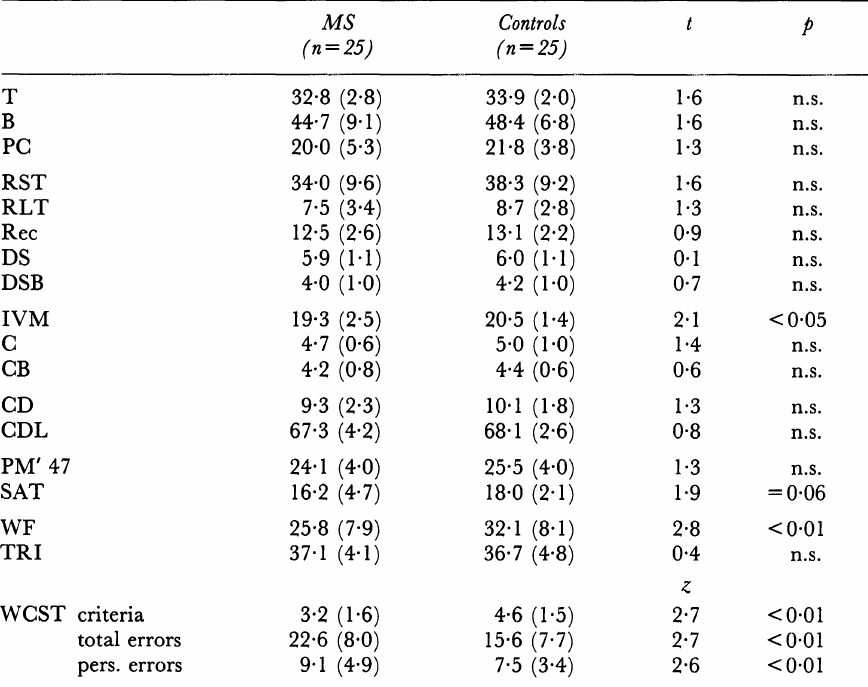
TABLE 5. Performance scores obtained on various tests of neuropsychological battery by the whole sample of MS and control subjects MS Controls p (n=25) (n =